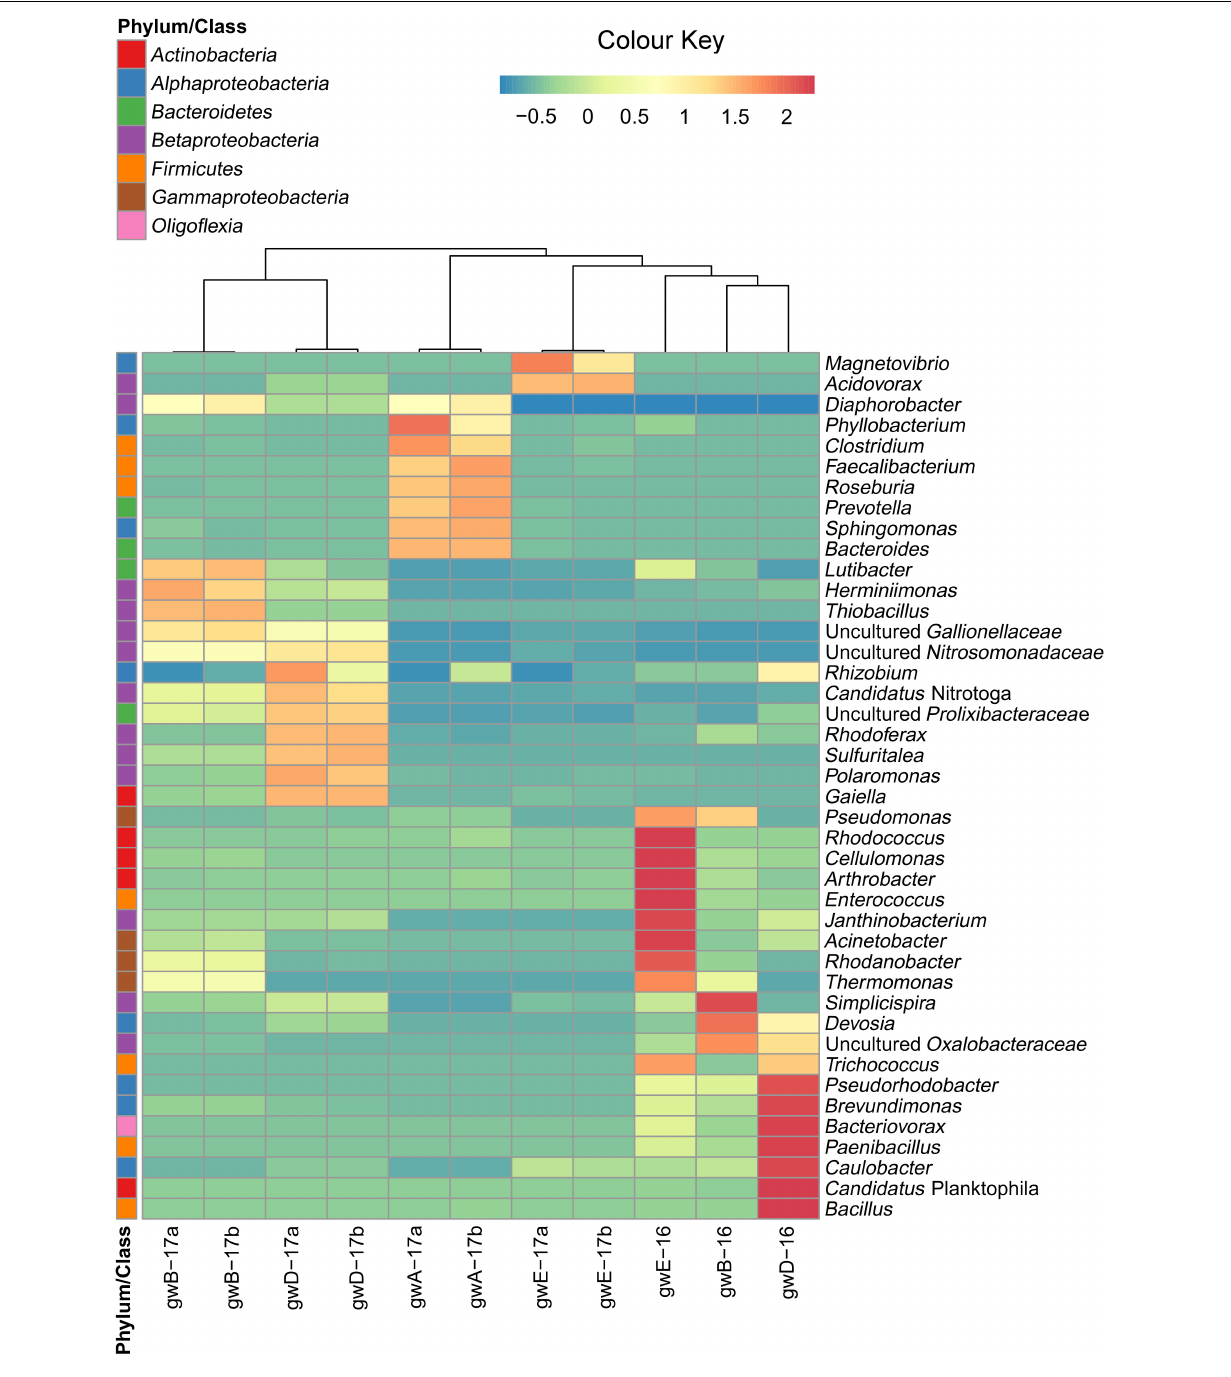
groundwater from wells B and E, were studied in more